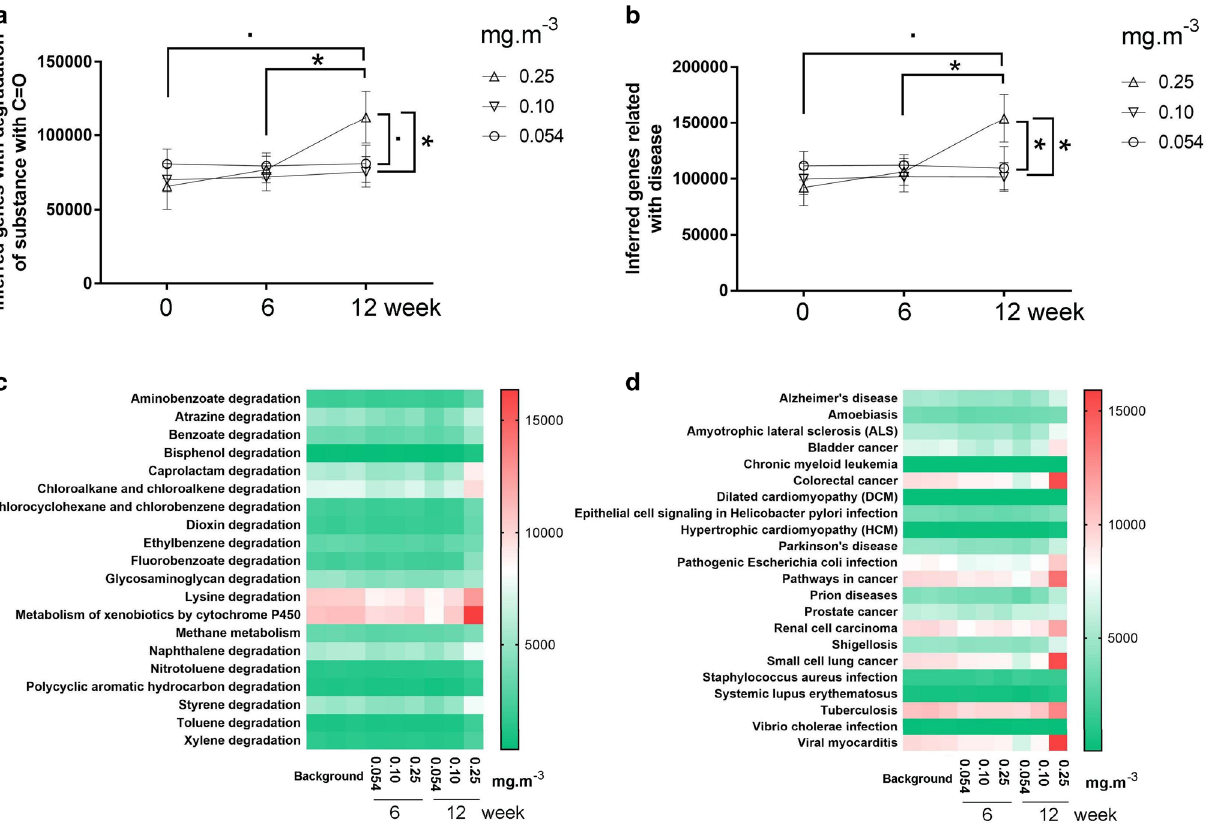
Figure 5. Analysis of the bacterial community’s function in different formaldehyde (CH 2 O) groups using the phylogenetic investigation of communities by reconstruction of unobserved states. Inferred genes of pathways related to the degradation of substance with C=O in different CH 2 O groups at different time points ( a ); inferred genes of pathways related to disease at different time points ( b ); heat map of inferred genes of pathways related to the degradation of substance with C=O in different CH 2 O groups at different time points ( c ); heat map of inferred genes of pathways related to disease in different CH 2 O groups at different time points ( d